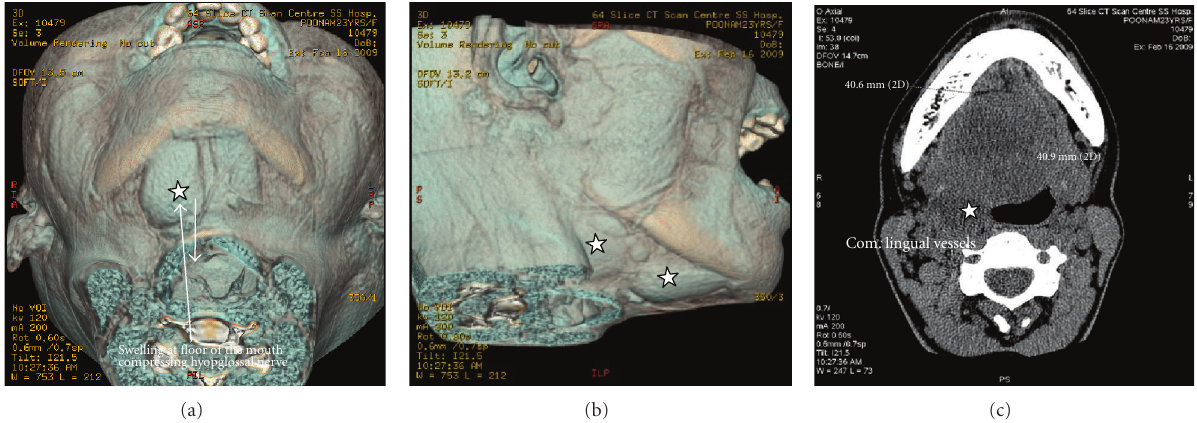
Figure 3: (a) and (b) CT scan of the soft tissue showing a di ff used swelling involving the carotid and digastric triangle on the right side ( ∗ ). (c) The swelling extending into the retropharyngeal space on the right side ( ∗